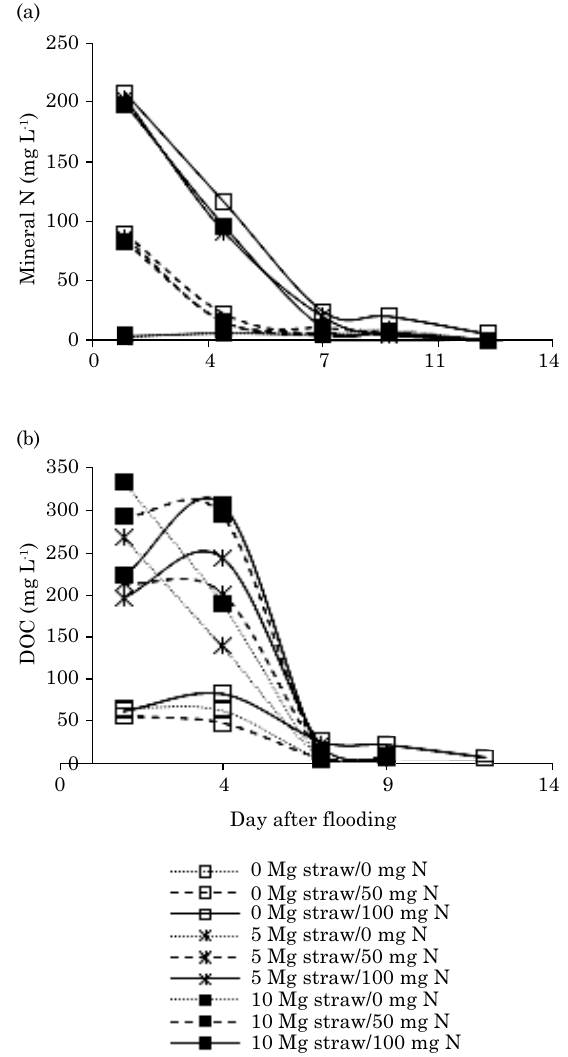
Figure 3. Levels of mineral N (a) and dissolved organic carbon - DOC (b) in the soil solution under different amounts of rice straw and rates of NO − 3